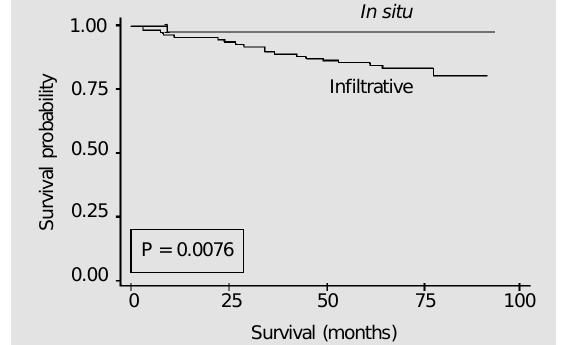
Figure 1. Kaplan-Meier survival estimates com- paring patients